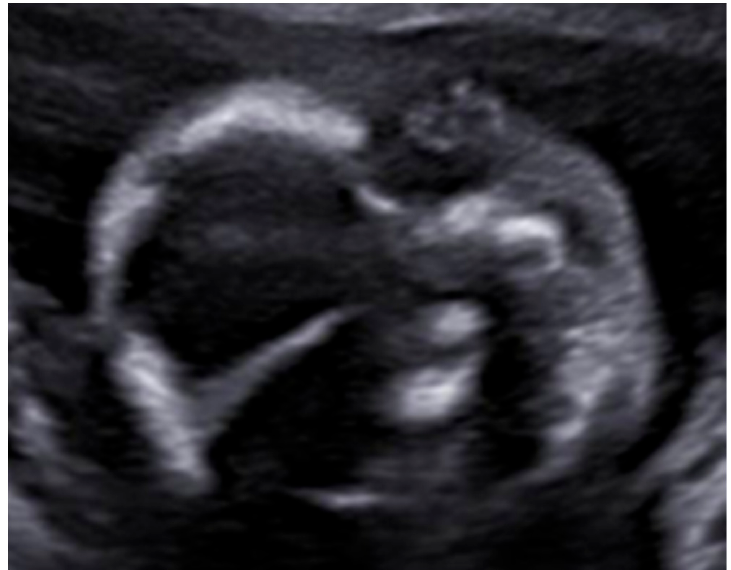
Figure 6. Initial ocular proptosis bilaterally.